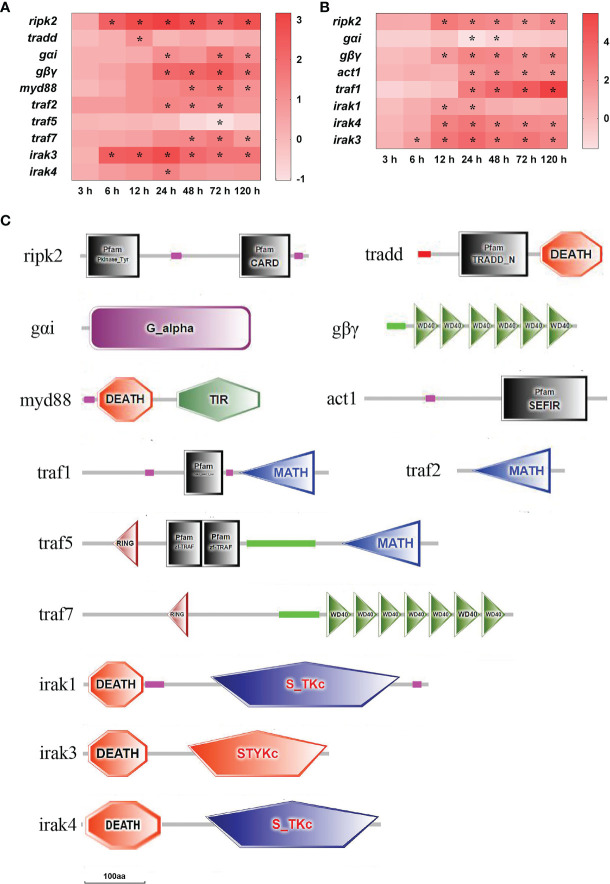
The DEGs of adaptor molecule in yellow catfish after E. ictaluri infection. (A, B): The DEGs identified in the spleen and liver, respectively. The DEGs of adaptor molecule were analyzed at 3 h, 6 h, 12 h, 24 h, 48 h, 72 h, and 120 h post-infection in the spleen and liver. The color gradient represents highly up-regulated (red) to highly down-regulated (white) genes. Significant differences at different time points post-infection compared to the control (0 h) are indicated by asterisks (*P < 0.05). (C): Structural features of adaptor molecule DEGs in yellow catfish. The domain organizations were predicted by the SMART online server.